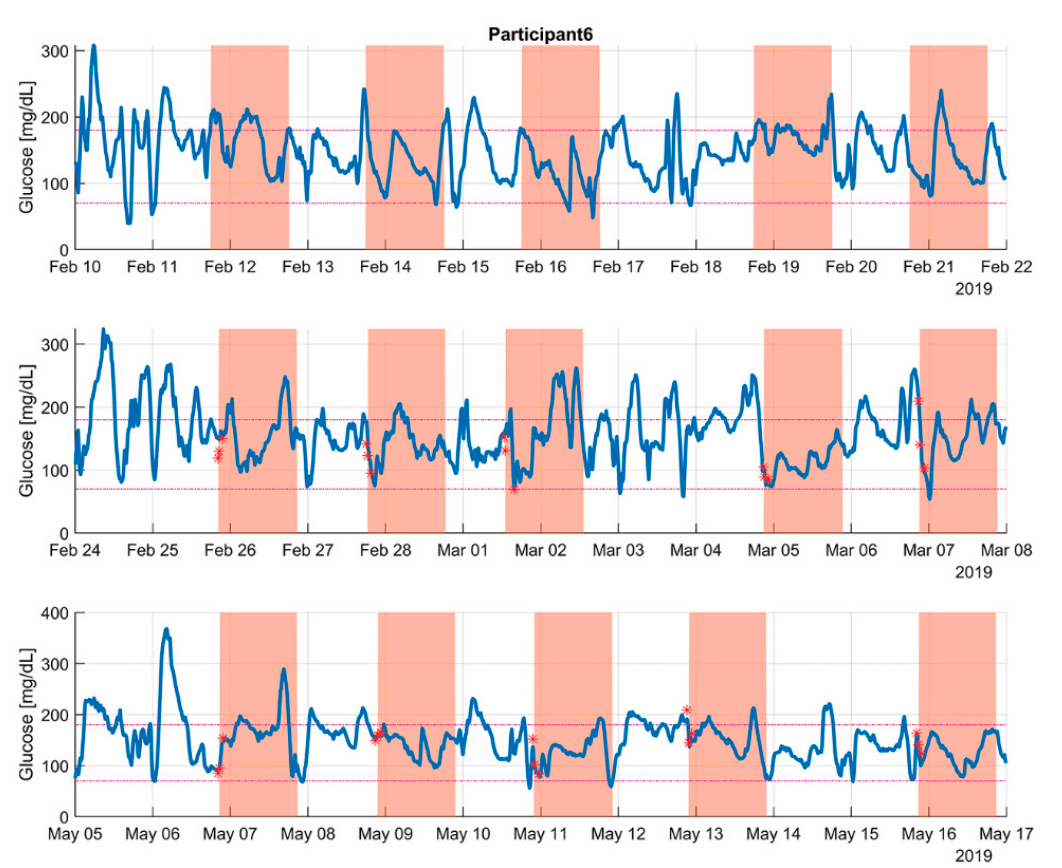
Figure 2. Illustration of the intermittent scanning CGM (isCGM) data from FLS for subject 6. Top row displays the baseline stage , middle row shows the first stage , and the bottom row the last stage . The 24-h post-exercise windows are shaded, and capillary measurements are displayed as red asterisks.